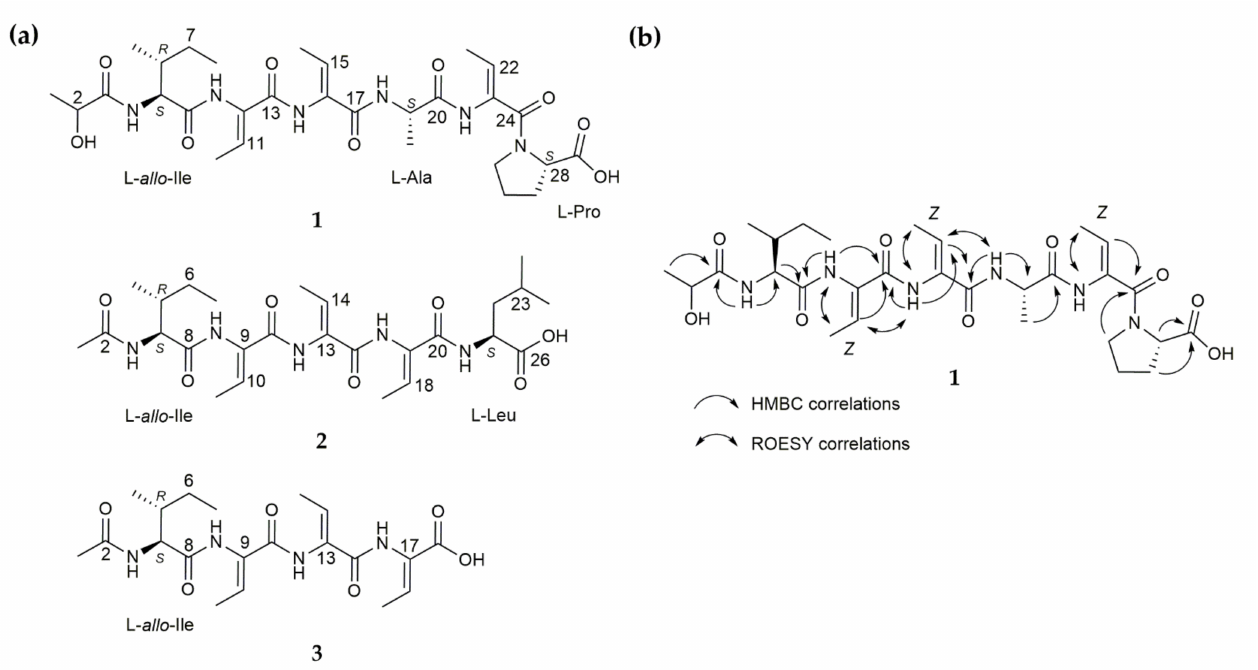
Figure 2. ( a ) Chemical structures of small peptide NPs scabimycins A ( 1 ), B ( 2 ) and C ( 3 ) isolated from S. acidiscabies (Lu19992); ( b ) Exemplary for scabimycin A: Key HMBC correlations that were used to assess the peptidic structure and through-space correlations measured by ROESY experiment (Rotational Nuclear Overhauser Effect Spectroscopy) that led to the Z -configuration of all dhbs in